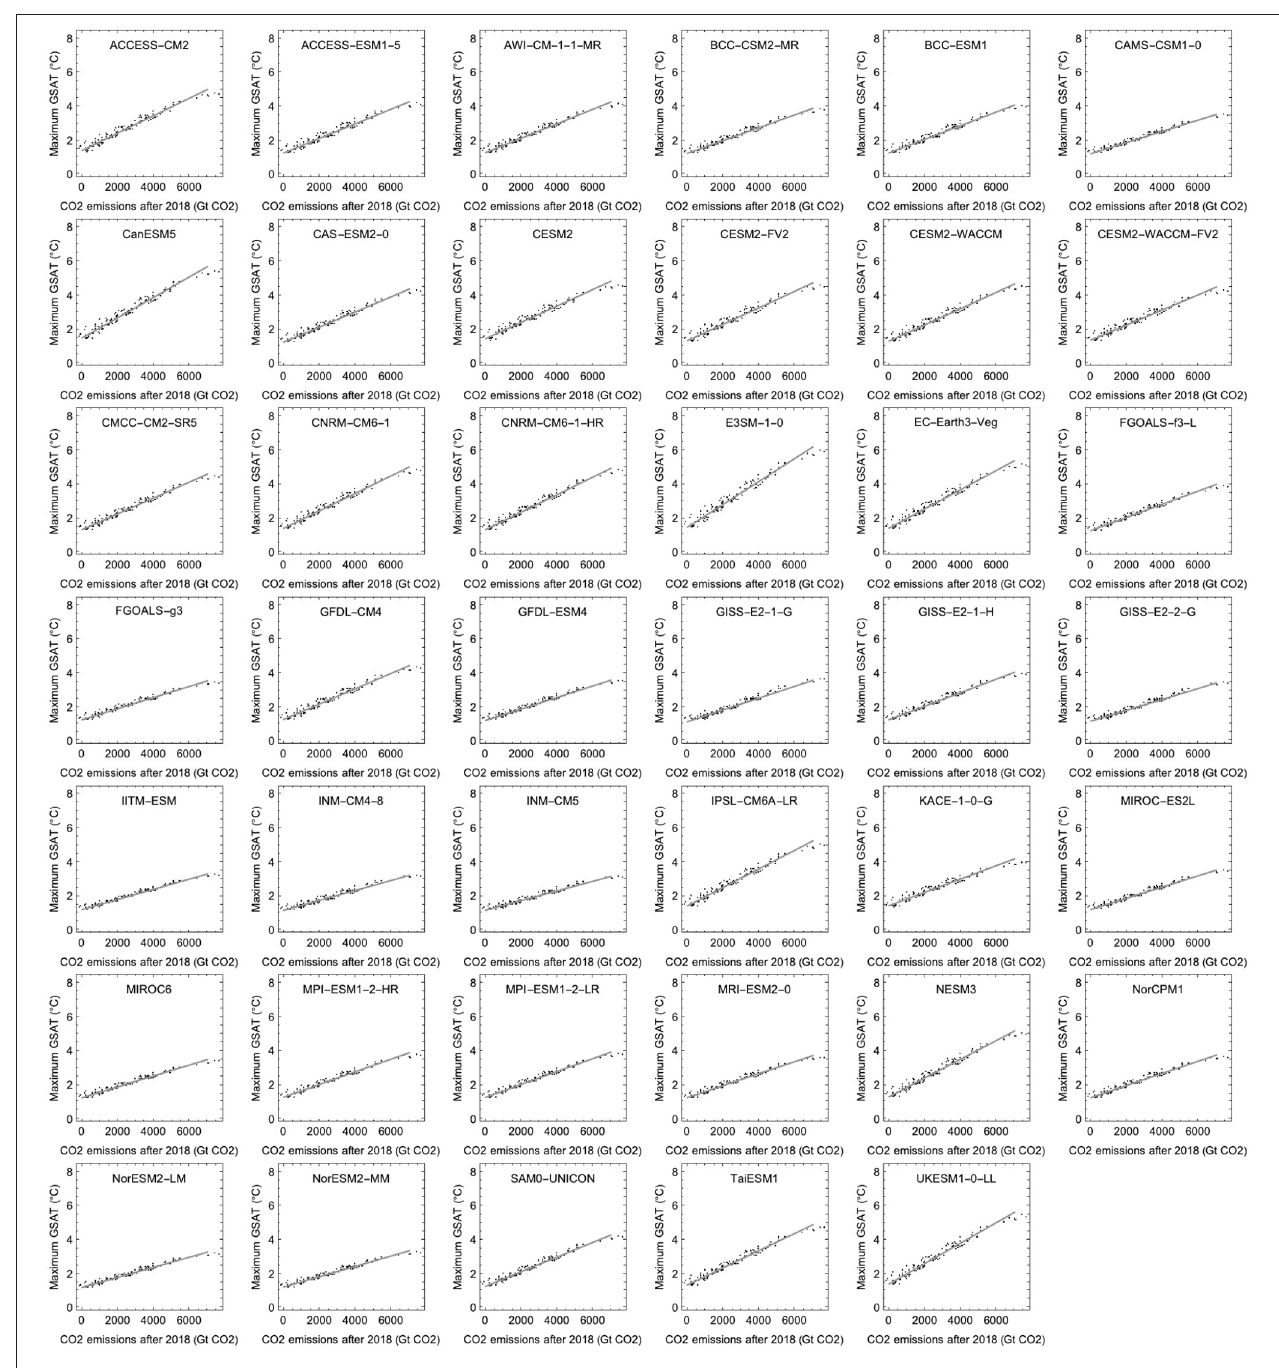
FIGURE 4 | Estimates of ETRCE. Each panel contains 127 points representing maximum GSAT vs. cumulative CO 2 emissions obtained from our simple emulator for the indicated CMIP6 ESM, i.e., each point represents one of the 127 emission scenarios. The parameters d 1 , d 2 , d 3 estimated for each ESM are shown in Table 1 . The regression lines demonstrate approximately linear relationships between total positive CO 2 emissions between 2018 and 2100 and the maximum GSAT for the ensemble of emission scenarios for each of the 41 different climate models in the CMIP6 ensemble. ETCRE estimates are obtained from the slopes of regression lines.